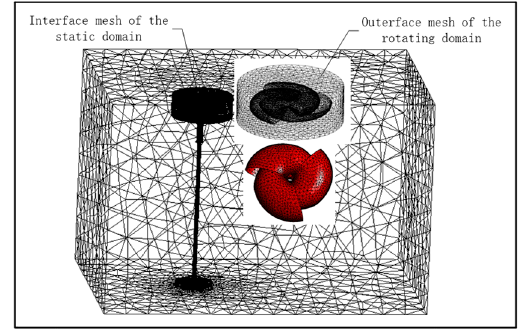
Figure 4. Schematic diagram of meshing.